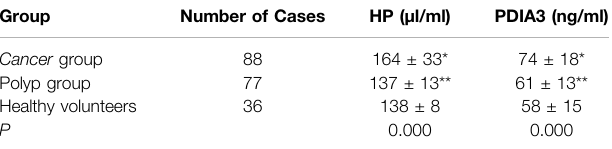
TABLE 1 | Comparison of HP and PDIA3 levels in “ cancer group ” , “ polyp group ” and “ group of healthy volunteers ” ( x ± s ). *vs. cancer group vs. healthy